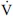
Differences in gas exchange of two representative PH patients (one shunt and one no shunt) and a normal subject.The responses of CPET in three female patients: one normal (aged 40 years; height, 160 cm; weight, 58 kg); one on-shunt-PH patient (aged 35 years; height, 157 cm; weight, 52 kg); and one shunt-patient (aged 38 years; height, 156 cm; weight, 54 kg). Symbols indicate 10-second averaged values. The course of CPET consisted of three minutes of rest, three minutes of unloaded cycling followed by increasing WR of 10 watts/min for PH patients and 20 watts/min for the control, and eventually four minutes of recovery. In the shunt-PH patient, PETO2, V˙E/V˙O2 (EqO2), V˙E/V˙CO2 (EqCO2) and RER concurrently abruptly increased while PETCO2 and SpO2 abruptly decreased. The no-shunt-PH patient showed less changes in PETCO2, PETO2, RER, V˙E/V˙O2 (EqO2), V˙E/V˙CO2 (EqCO2) and SpO2.